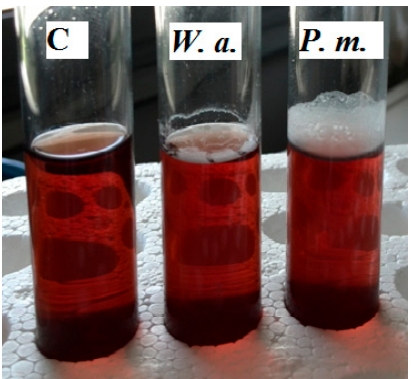
Figure 4. Production of yeast film by W. anomalus and P. manshurica isolated from the Taggiasca brines and inoculated in the same medium after microfiltration sterilization (C, uninoculated control; W.a. , W. anomalus ; and P.m. , P. manshurica ).